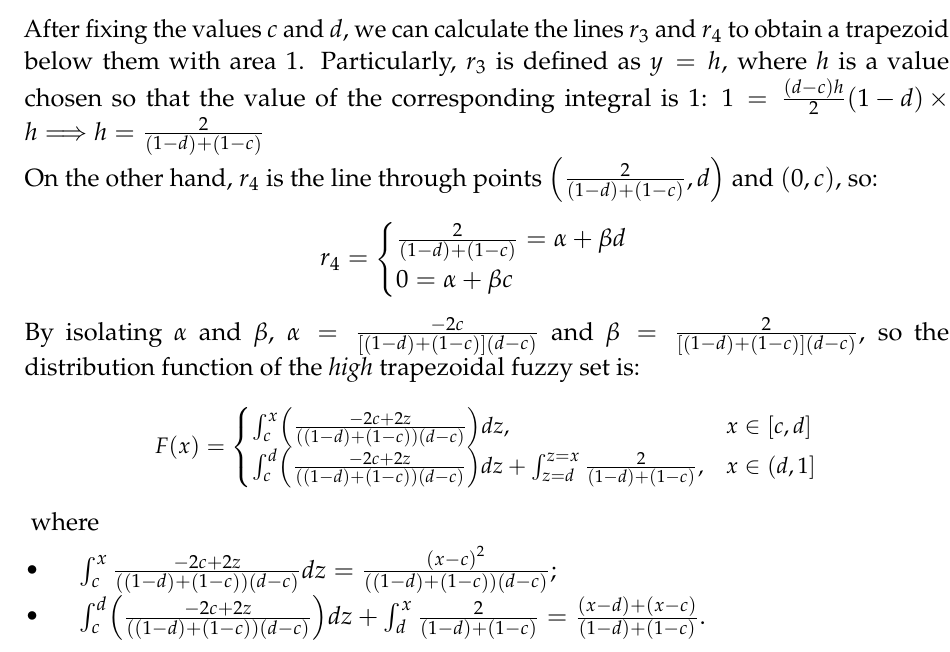
trapezoidal fuzzy set. Figure 7. High